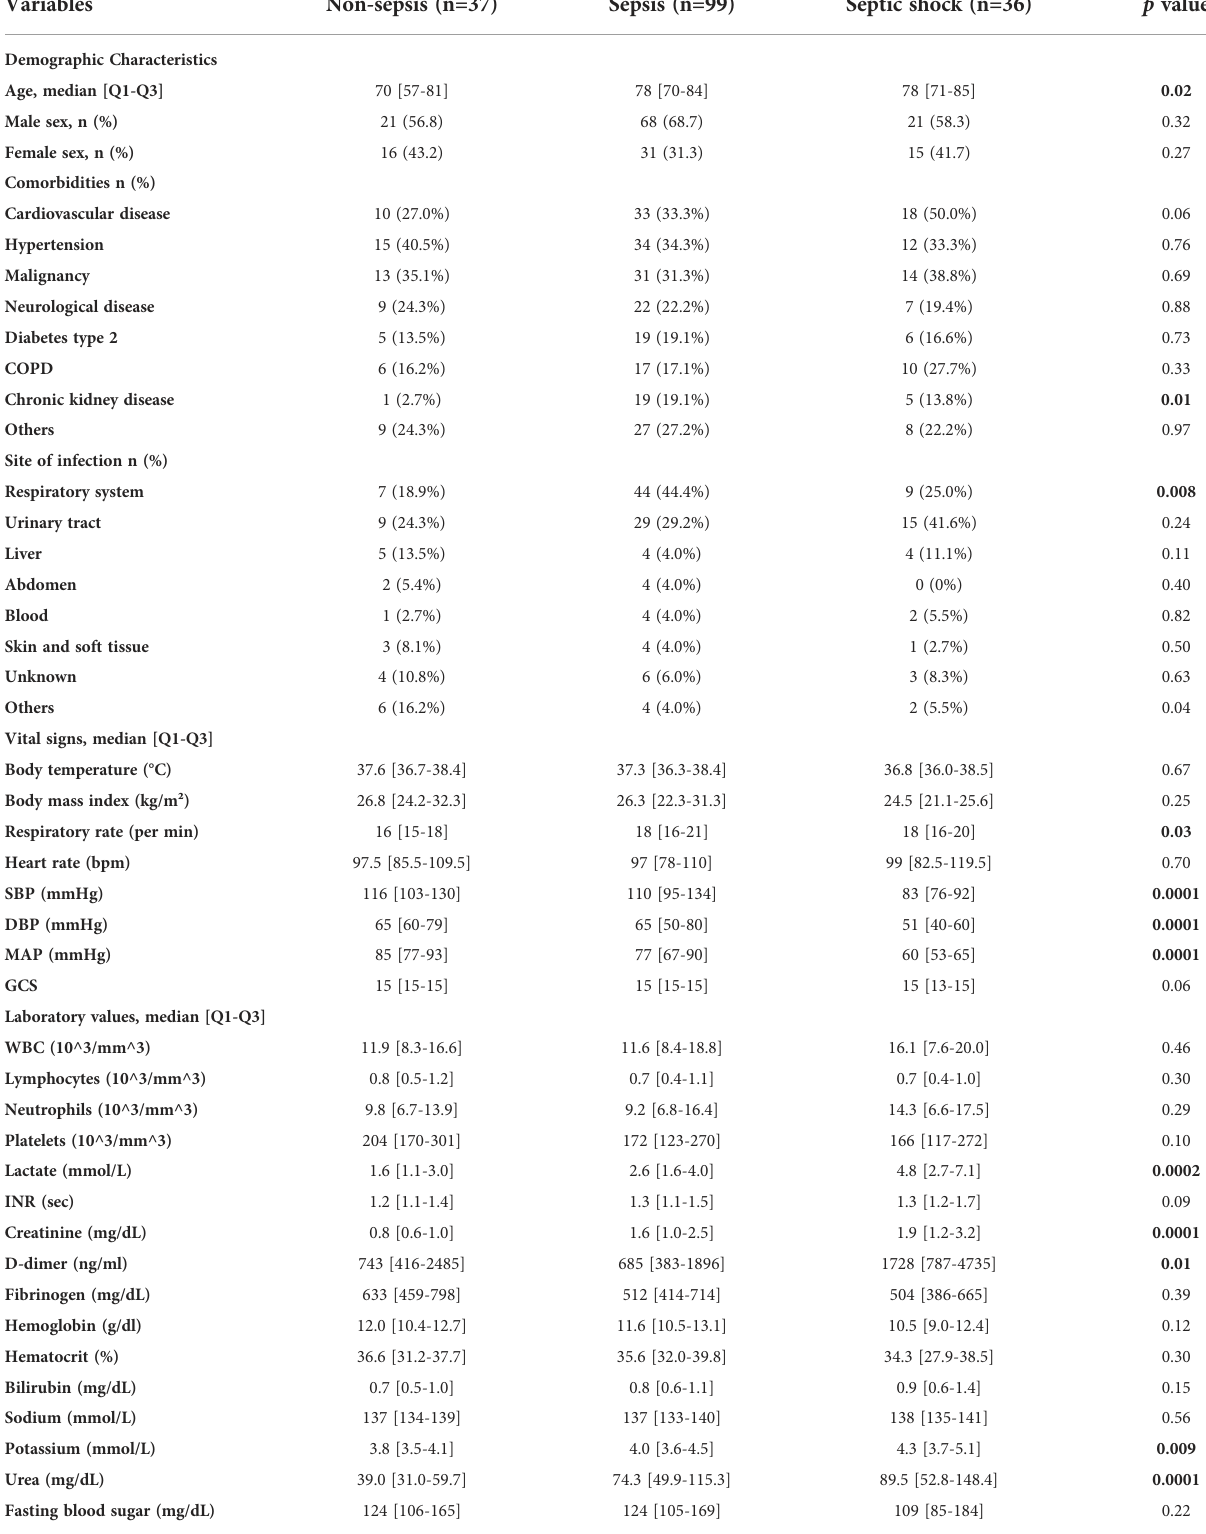
TABLE 1 Demographic, laboratory and clinical characteristics of the entire patients population on day